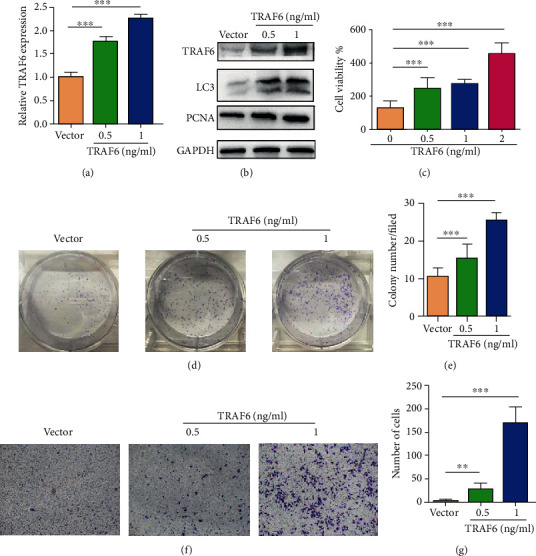
Overexpression of TRAF6 promoted cell proliferation and migration in HGC-27 gastric cancer cells. (a) Real-time PCR revealed TRAF6 expression in transfected vector and TRAF6 plasmid HGC-27 cells (n = 3, ∗∗∗p < .0001). (b) Western blot was used to confirm the expressions of TRAF6, PCNA, and LC3 in transfected vector and TRAF6 plasmid HGC-27 cells. (c) CCK8 assay for transfected vector and TRAF6 plasmid HGC-27 cells; cells were incubated at 37°C for 72 h. (d) Representative images of colony formation for transfected vector and TRAF6 plasmid HGC-27 cells and cells were cultured for 1 week. (e) Number of clones in (d) (n = 3, ∗∗∗p < .0001). (f) Transwell migration assay for transfected vector and TRAF6 plasmid HGC-27 cells. (g) Number of migrating cells in (f) (n = 3, ∗∗∗p < .0001).